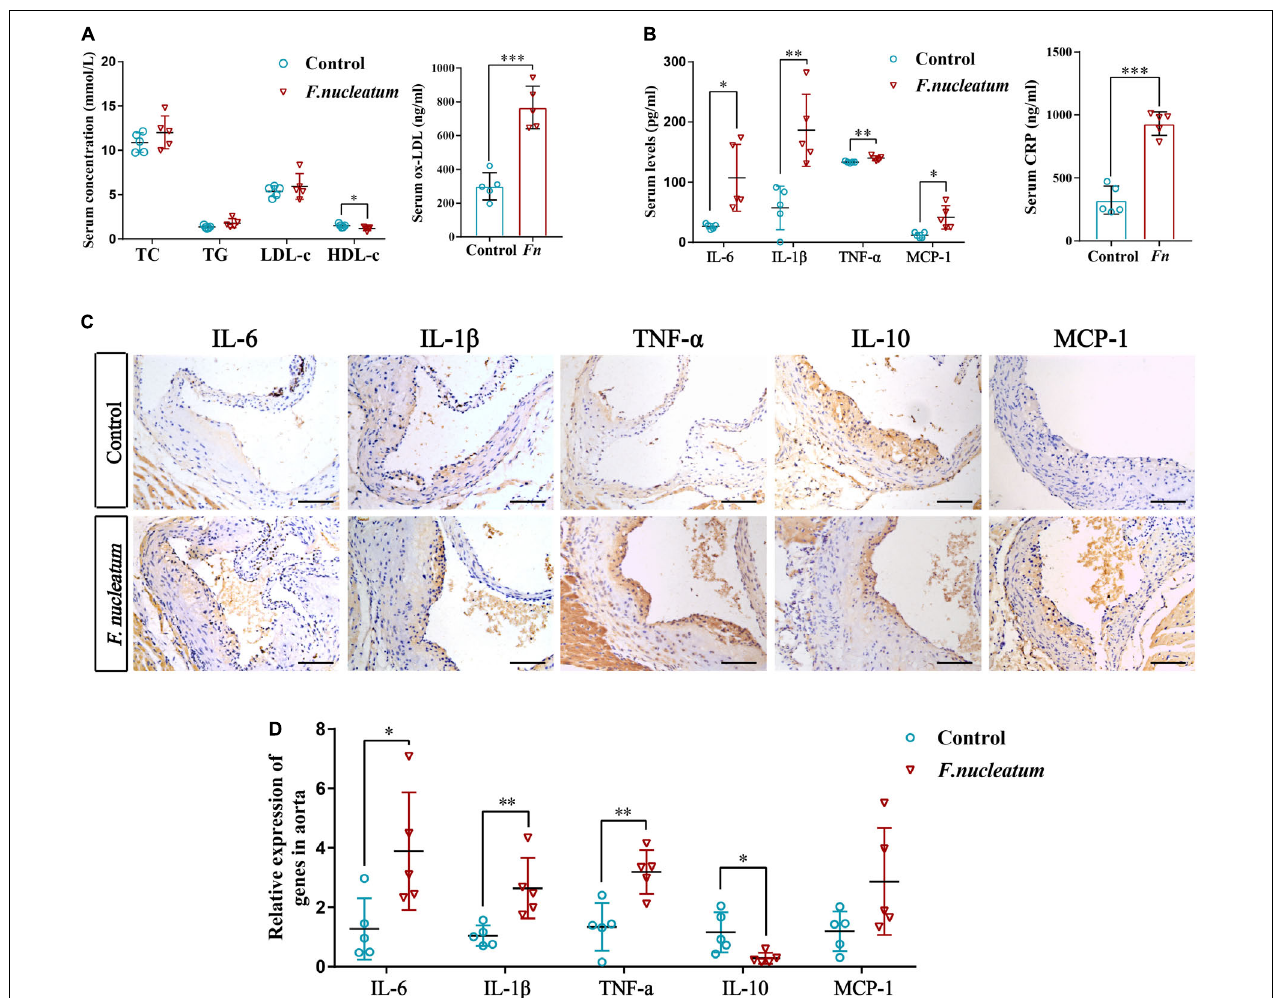
FIGURE 3 | F. nucleatum alters serum lipid profiles and systemic cytokine levels. (A) Serum levels of total cholesterol (TC), total triglyceride (TG), high-density lipoprotein cholesterol (HDL-c), low-density lipoprotein cholesterol (LDL-c), and oxidized low-density lipoprotein (ox-LDL) ( n = 5, each group). (B) Serum levels of proinflammatory cytokines TNF- α , IL-1 β , IL-6, CRP, and chemokine MCP-1 ( n = 5, each group). (C) Inflammatory mediators in the aortic tissues are shown by immunohistochemical staining; Scale bars, 100 µ m. (D) Data are expressed as the relative mRNA levels in the aortic tissues ( n = 5, each group). All data